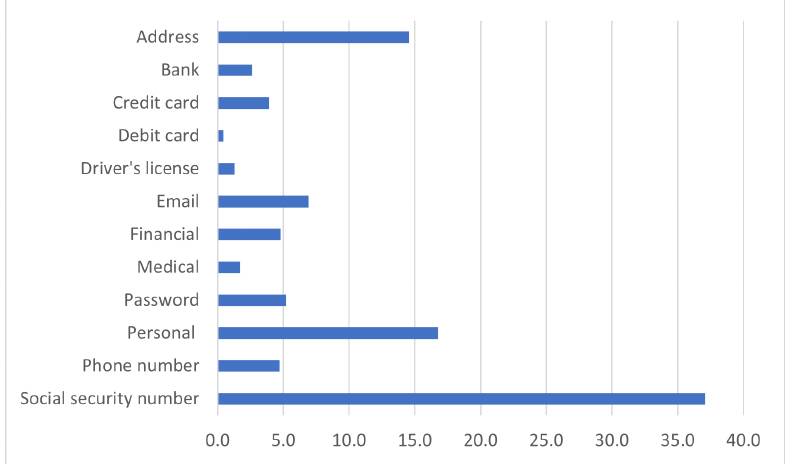
Figure 1. Overview of breached data record types ( y -axis) and percentages ( x -axis) from Mello [53], approximate n =